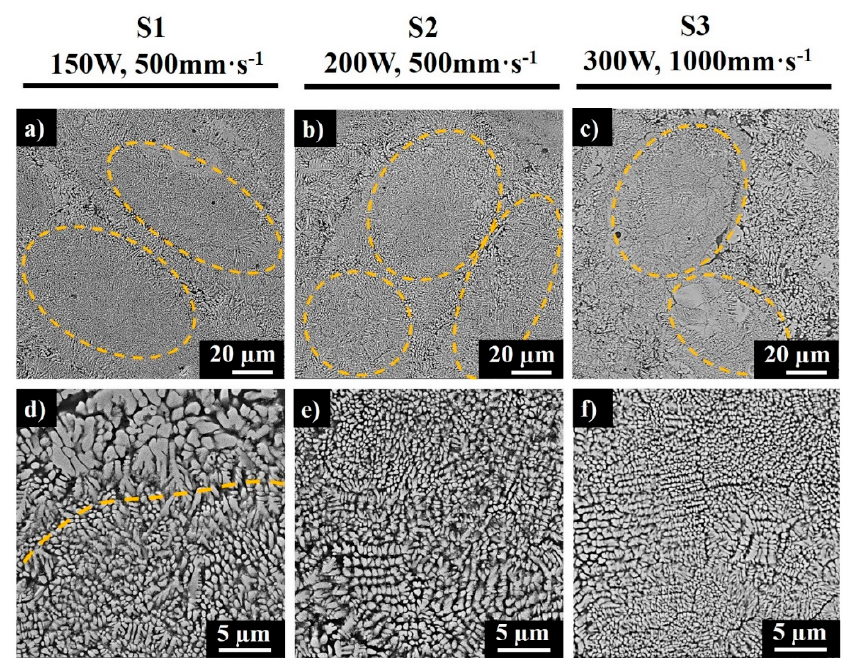
Figure 6. SEM images of polished top surfaces of samples S1 ( a , d ), S2 ( b , e ), and S3 ( c , f ).